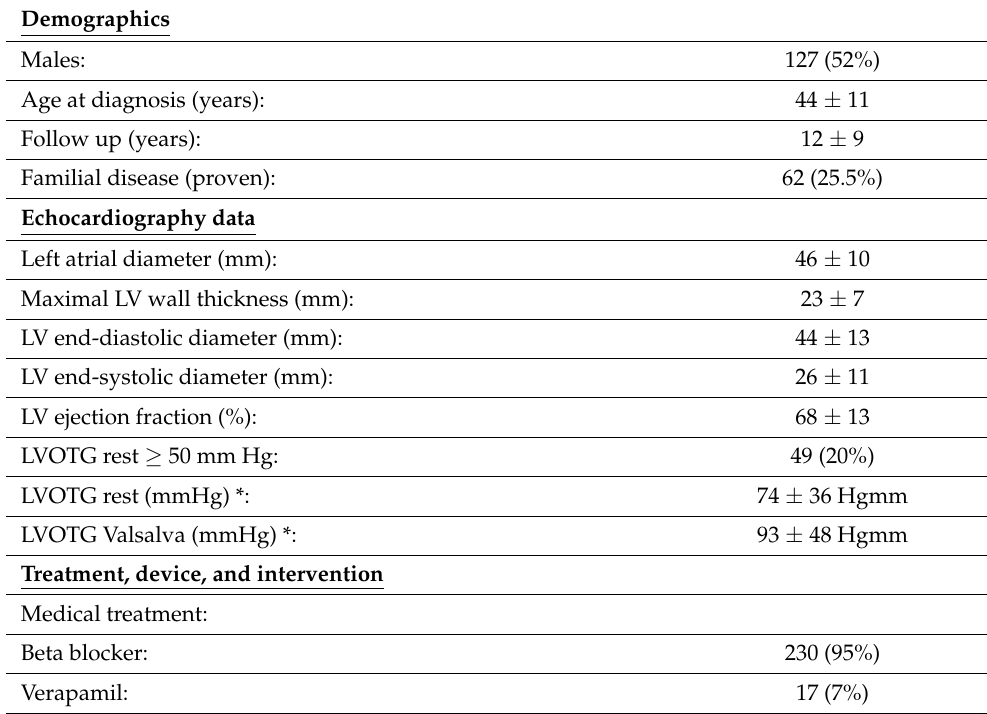
Table 1. Main demographic, clinical, and echocardiographic characteristics of the studied